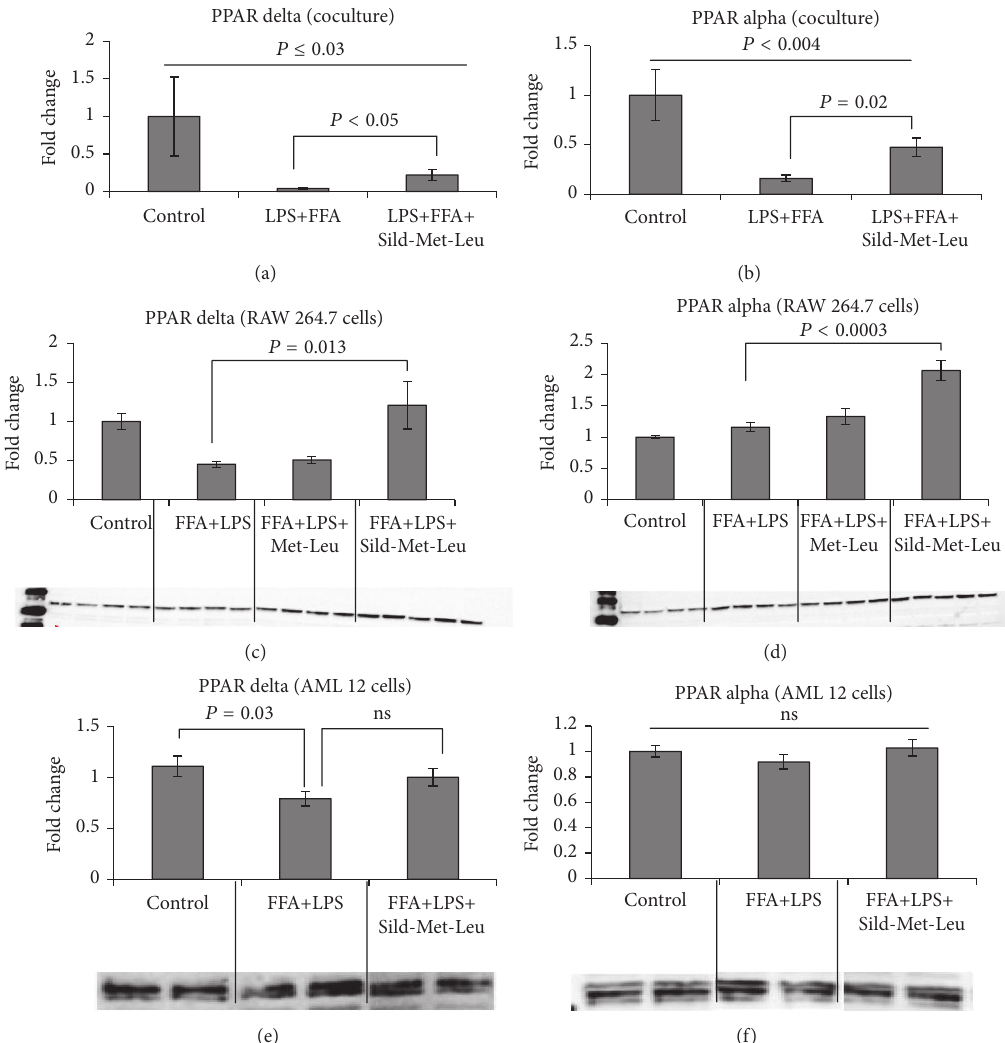
Figure 4: Sild-Met-Leu treatment increases PPAR alpha and delta in mouse hepatocyte-macrophage coculture. Mouse hepatocytes and macrophages, grown individually or in coculture, were treated with sildenafil (1nM), metformin (0.1mM), and leucine (0.5 mM) as indicated for 24 hours after induction with free fatty acids (FFA) and LPS. Nontreated cells with induction with FFA and LPS (FFA + LPS) or without (control) were included for comparison. ((a) and (b)) Gene expression of PPAR alpha and delta in hepatocyte-macrophage coculture. Data are represented as mean ± SEM of fold change of control ( 𝑛 = 6 to 8). ((c) to (f)) Protein expression of PPAR alpha and delta in RAW 264.7 macrophages and in in AML 12 hepatocytes. Quantitative data are presented as mean ± SEM ( 𝑛 = 4 to 5), and representative blots are